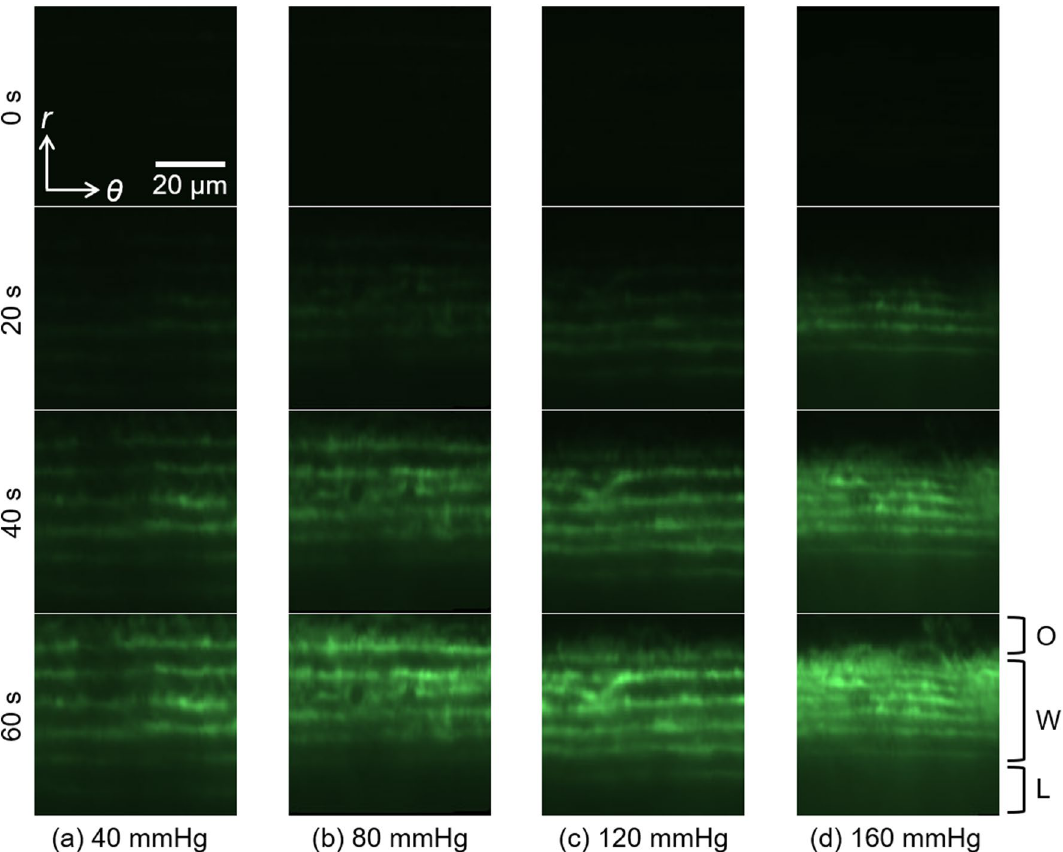
Figure 3. Time-lapsed images of fluorescence in the aortic walls in the radial-circumferential ( r – θ ) cross- section at intraluminal pressures of ( a ) 40, ( b ) 80, ( c ) 120, and ( d ) 160 mmHg at 0, 20, 40, and 60 s after t start . From the top to the bottom sides, the outside of the aorta (O), aortic wall (W), and lumen (L) are shown. The image was created using ImageJ